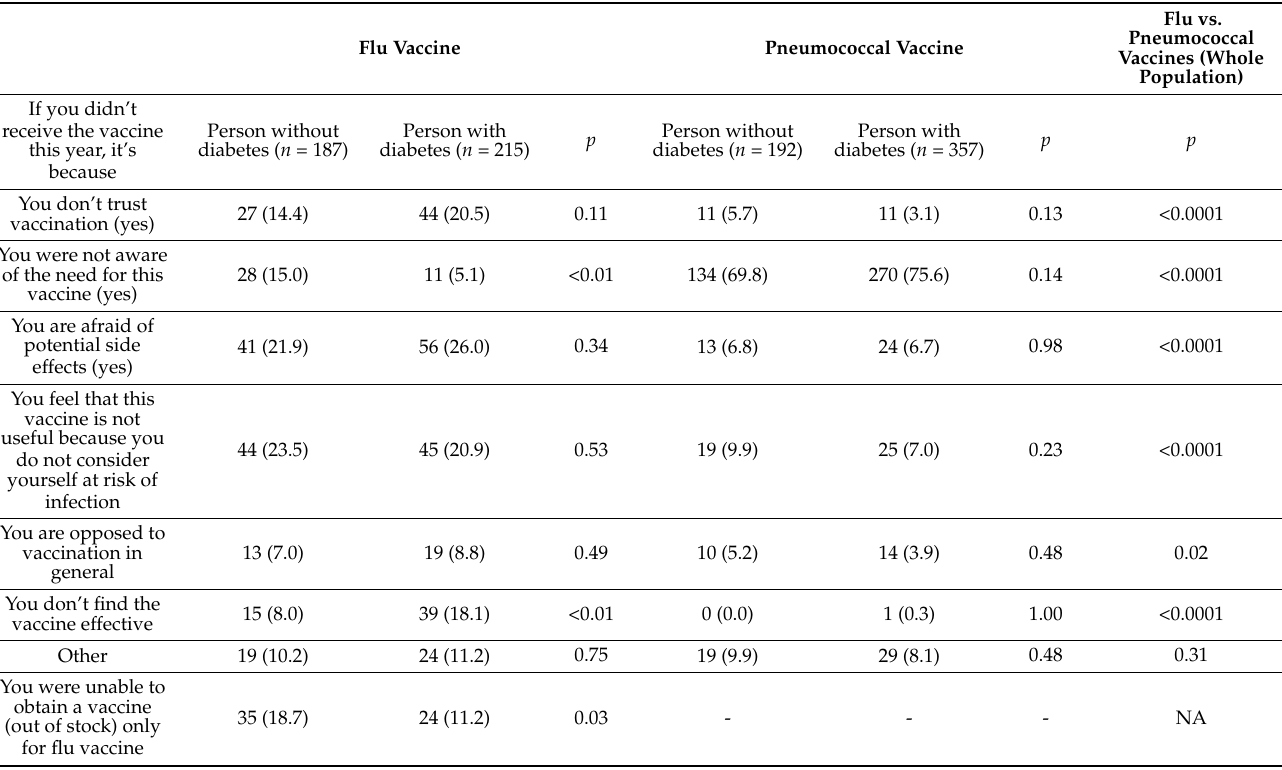
Table 3. Reasons for